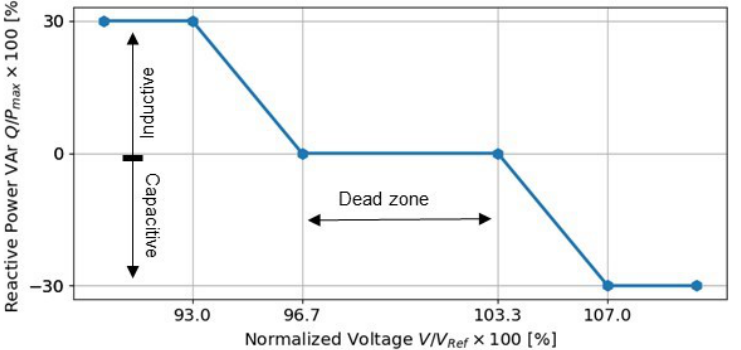
Figure 15. California Rule 21 Volt-VAr Optimization curve.